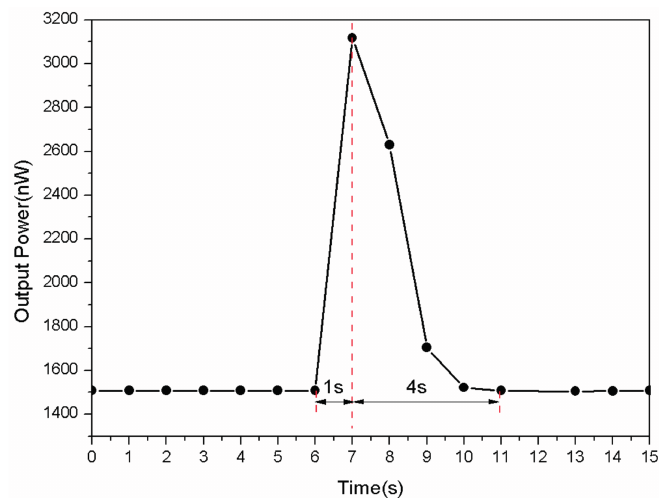
Figure 6. The response and recovery time of the proposed sensor with a bend radius of 8 mm.